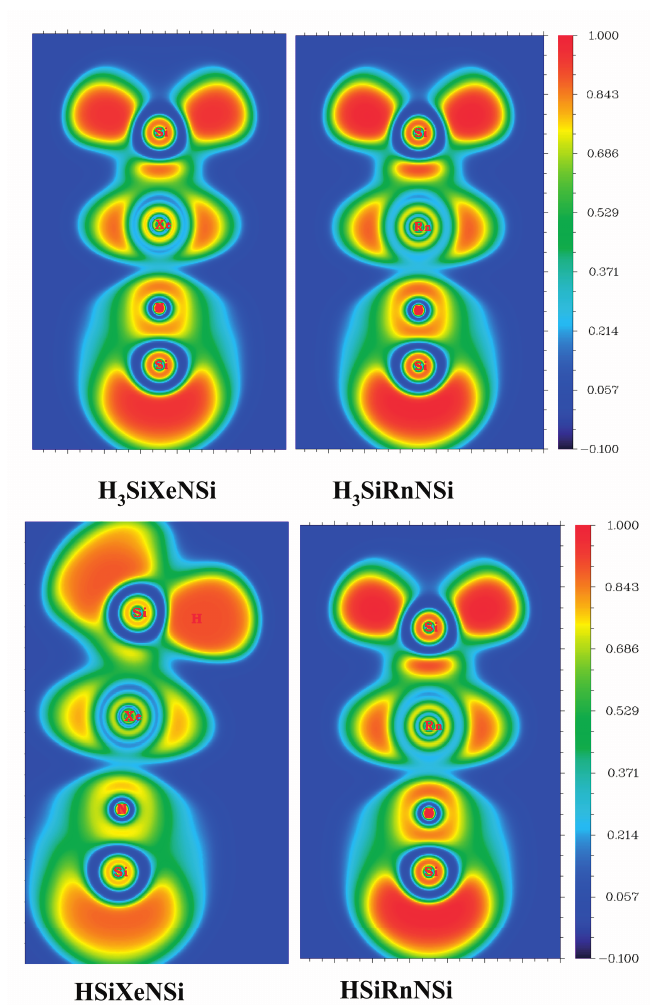
Figure 3. Color-filled maps of the electron localization function of H 3 SiXeNSi and HSiXeNSi clusters at a particular plane computed at the MP2/def2-QZVPPD/WTBS level (WTBS is used for Xe and